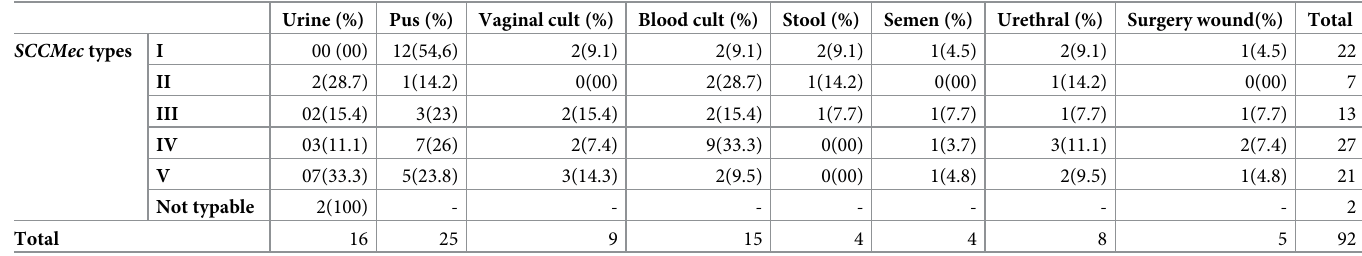
Table 3. SCCmec typing of MRSA isolates.